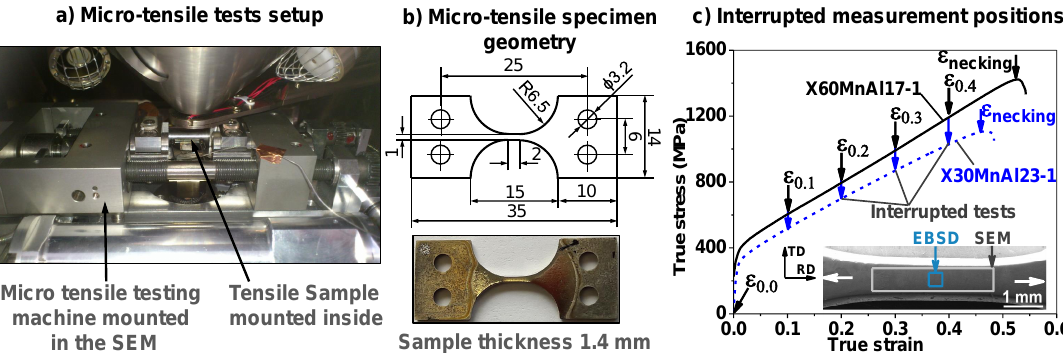
Figure 1. In-situ micro-tensile tests in conjunction with scanning electron microscope (SEM) and electron backscatter diffraction (EBSD): ( a ) test setup, ( b ) specimen geometry, ( c ) true stress-strain curves obtained for X60MnAl17-1 and X30MnAl23-1; tests were carried out with a crosshead displacement rate of 0.2 mm/min, which corresponds to a quasi-static ˙ ε of about 0.001 s − 1 and interrupted at different strains as pointed to observe the microstructure and micro-crack development; EBSD measurement area and the region of SEM investigations on the micro-tensile specimen is shown; white arrows indicate tensile loading